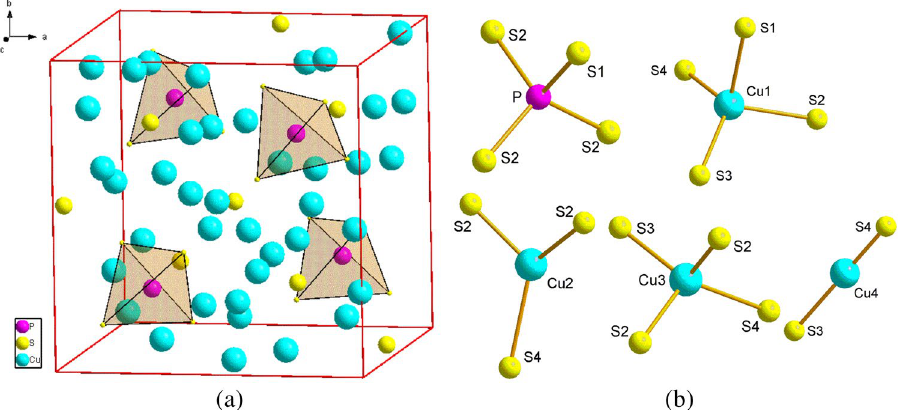
Figure 1. ( a ) The cubic space group P 2 1 3 framework of Cu 7 PS 6 , ( b ) nearest coordination environment of P and Cu